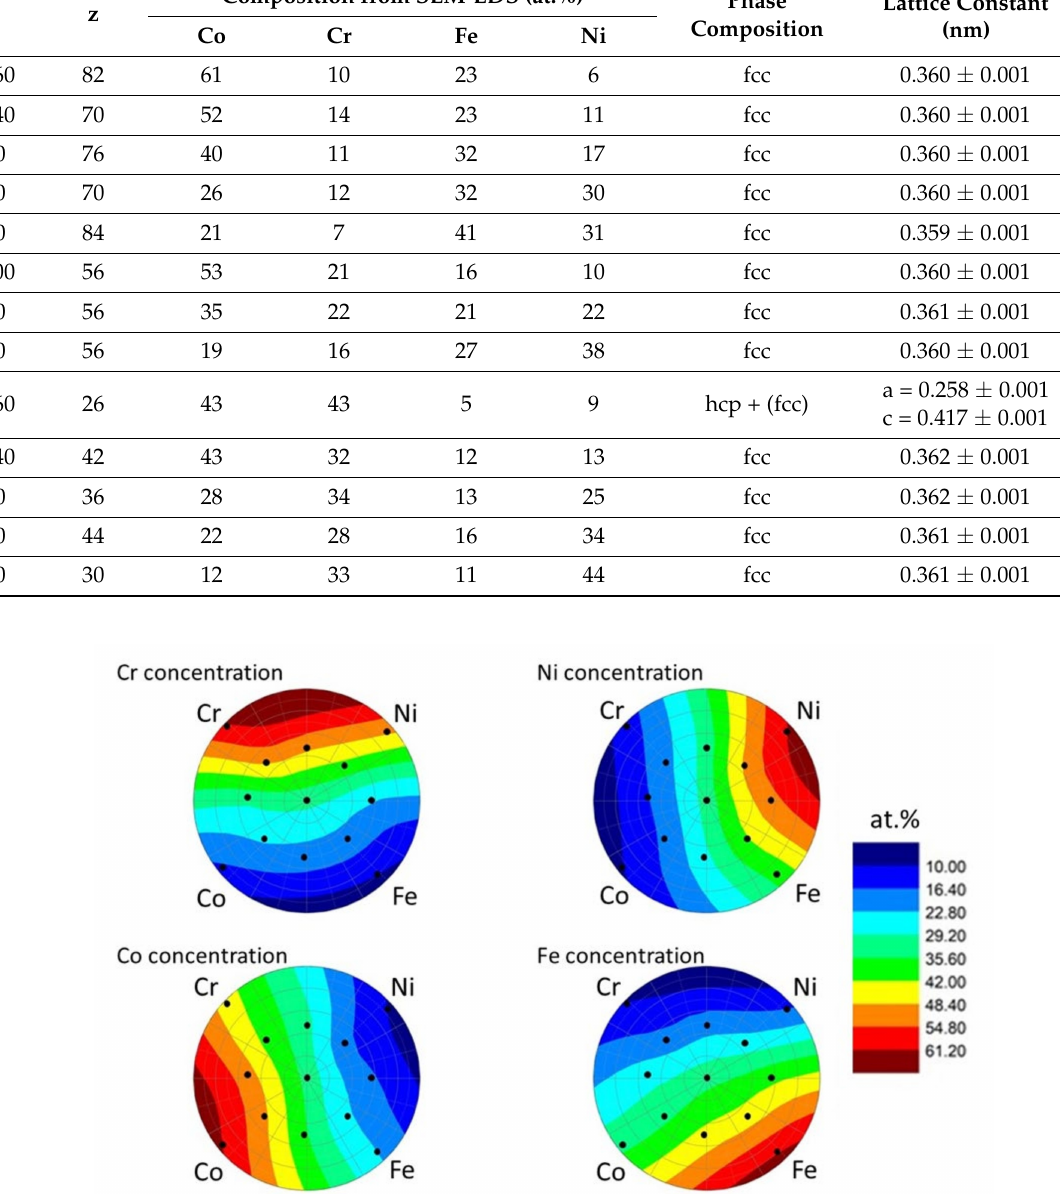
Table 1. The coordinates of the studied positions (y and z), the chemical composition obtained by SEM-EDS, as well as the phase composition and the lattice constants determined by XRD. Composition from SEM-EDS (at.%)